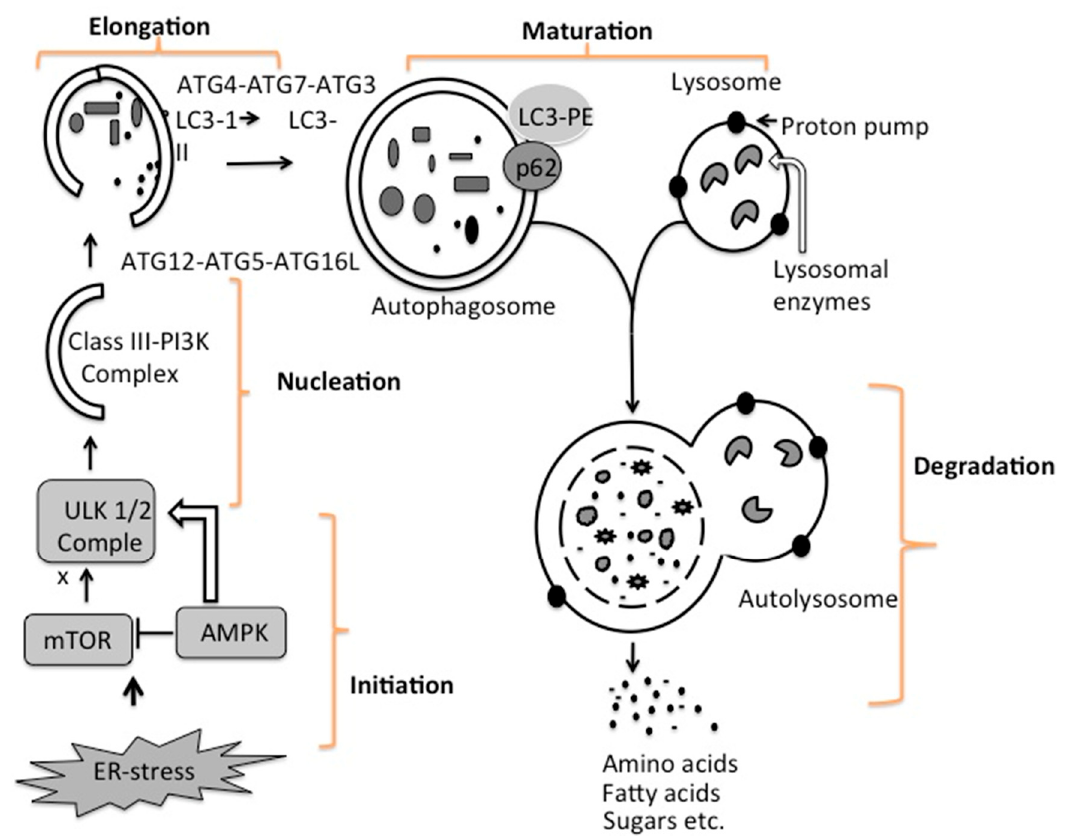
Figure 5. Molecular interactions involved in macroautophagy. Activation of unfolded protein response due to HCV replication in the ER initiates autophagy through direct or indirect activation of genes involved in autophagy. Autophagy responses also initiated due to low energy conditions by AMP ‐ activated kinase (AMPK) and mechanistic target of rapamycin complex 1 (mTOR1). The phosphorylation of the ULK complex can be initiated by AMPK activation due to low ATP or mTOR inhibition due to low nutrients sensing. Activation of ULK complex initiates a series of reactions that leads to the engulfment of the cellular constituents in a double ‐ membrane structure called autophagosome. The autophagosome then fuses with lysosome to form autophagolysosome in which the contents are digested by lysosomal enzymes into basic nutrients (sugars, lipids, amino acids and nucleosides), which are released into the cytoplasm for subsequent use. (Figure adapted from [102]).